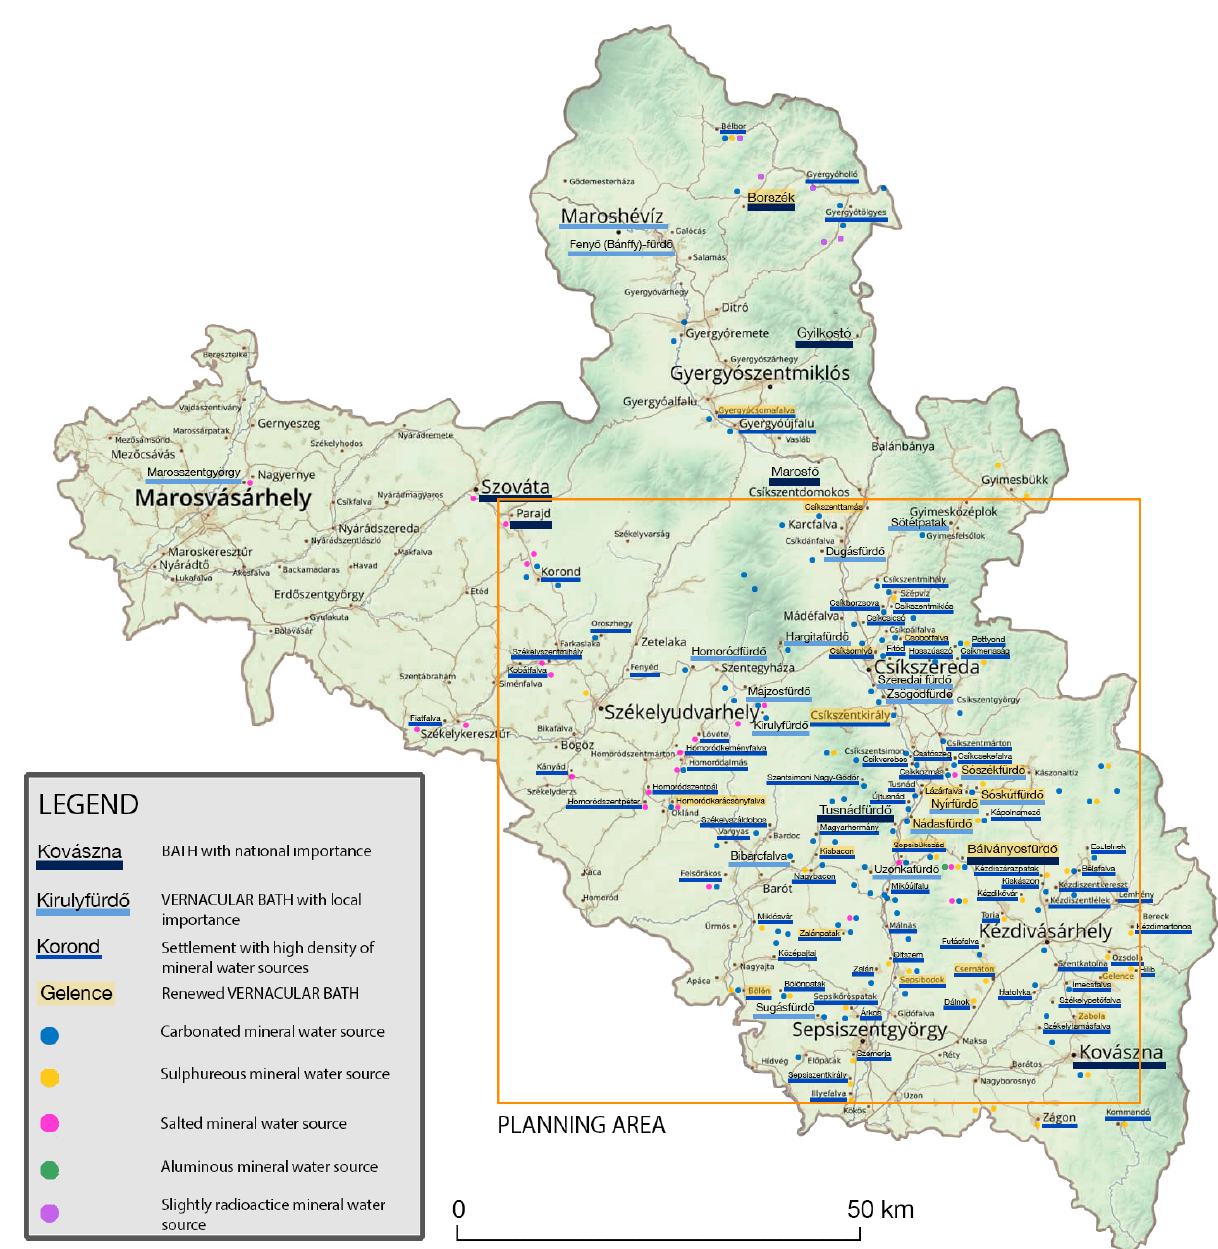
Figure 3. Map of mineral water sources of Szeklerland. The map shows among different hydrogeological aspects the location of bath building volunteer camps in Szeklerland. Source: prepared by the authors and technical contribution of Maja Erdei based on the map of Zsigmond Enik˝o [45] and own research of the